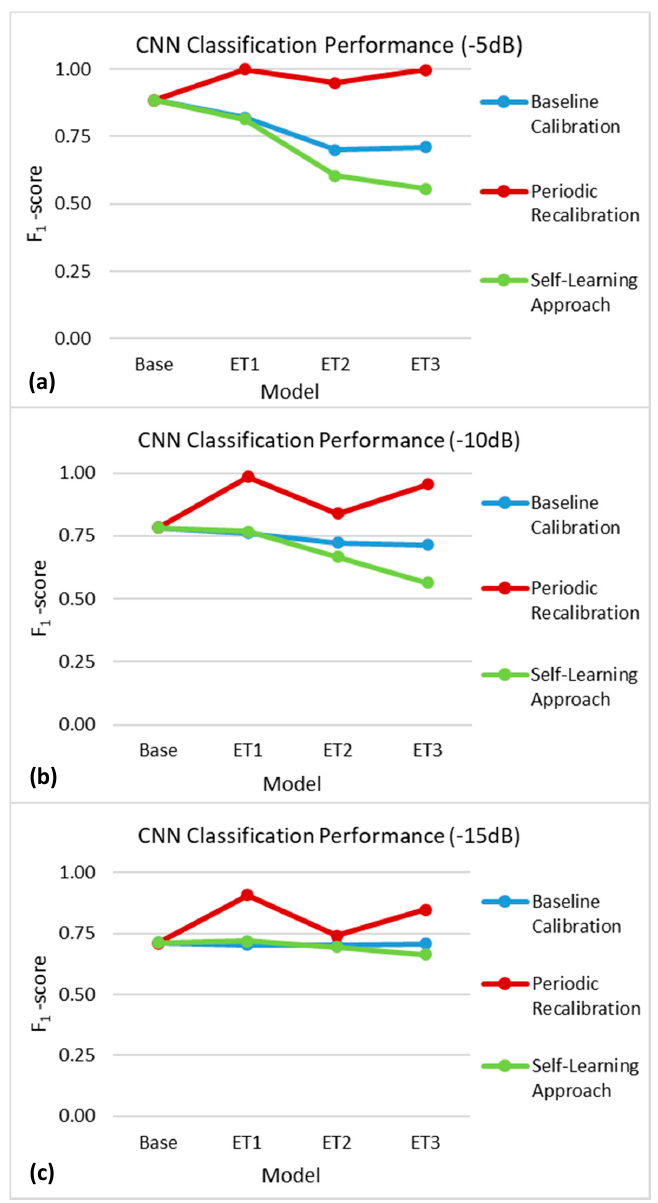
Figure 8. F 1 -scores obtained in the encapsulation tissue simulation using the baseline calibration (blue), periodic recalibration (red), and self-learning (green) update approaches at different time points (represented here as additional models) using measurements with ( a ) − 5 dB, ( b ) − 10 dB, and ( c ) − 15 dB of noise added. The standard deviations at each time point were all below 0.007 and are therefore not displayed here for ease of visualization.